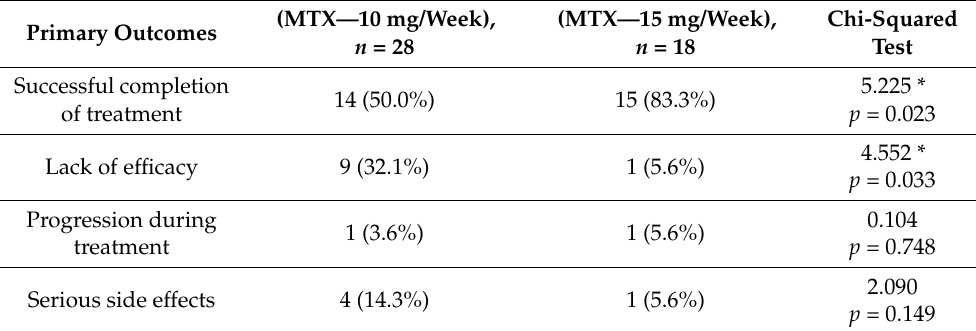
Table 3. Primary outcomes of patients with pulmonary sarcoidosis depending on the dose of